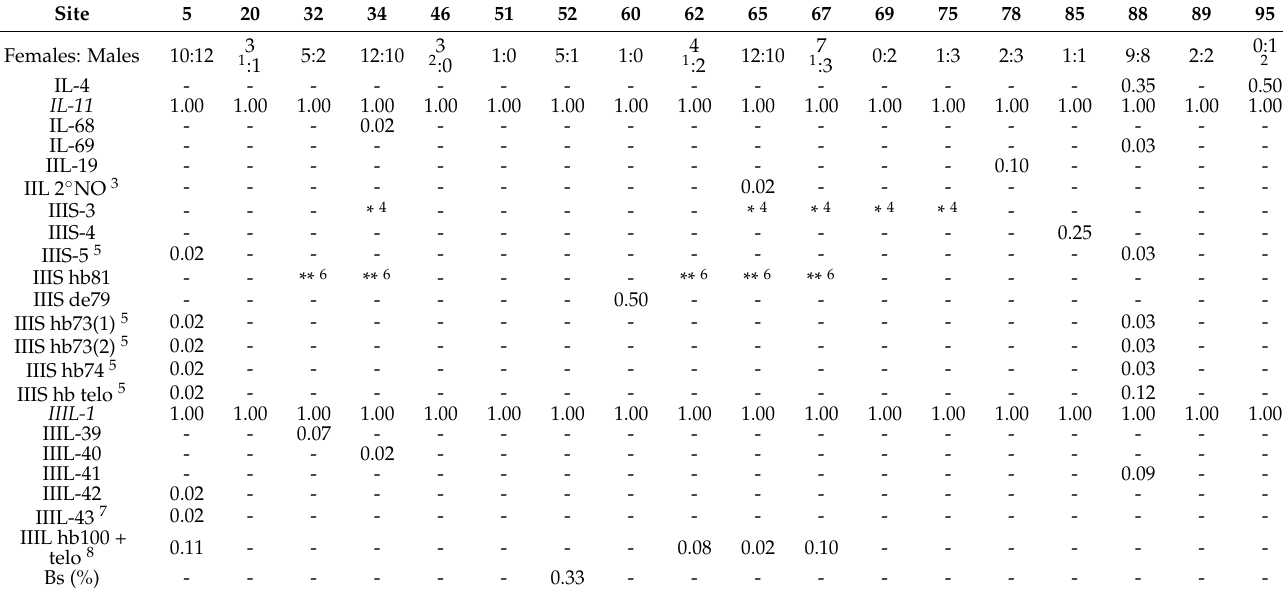
Table 2. Frequency of all rearrangements in chromosomal constituents relative to the Simulium subgeneric banding sequence and frequency of B chromosomes for larvae of the Simulium ornatum group collected in Kyrgyzstan, June–July 2015.